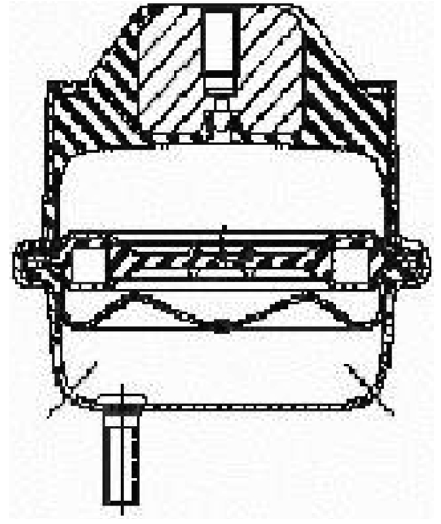
Fig. 3. A single pumper passive fluid